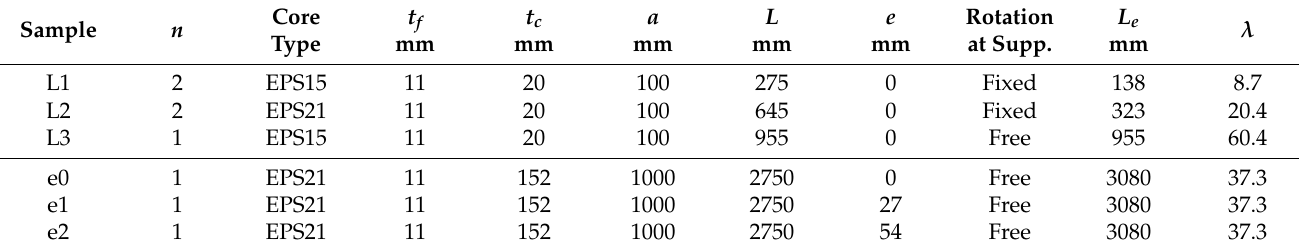
Table 1. CSIP samples’ geometry and test setup parameters.